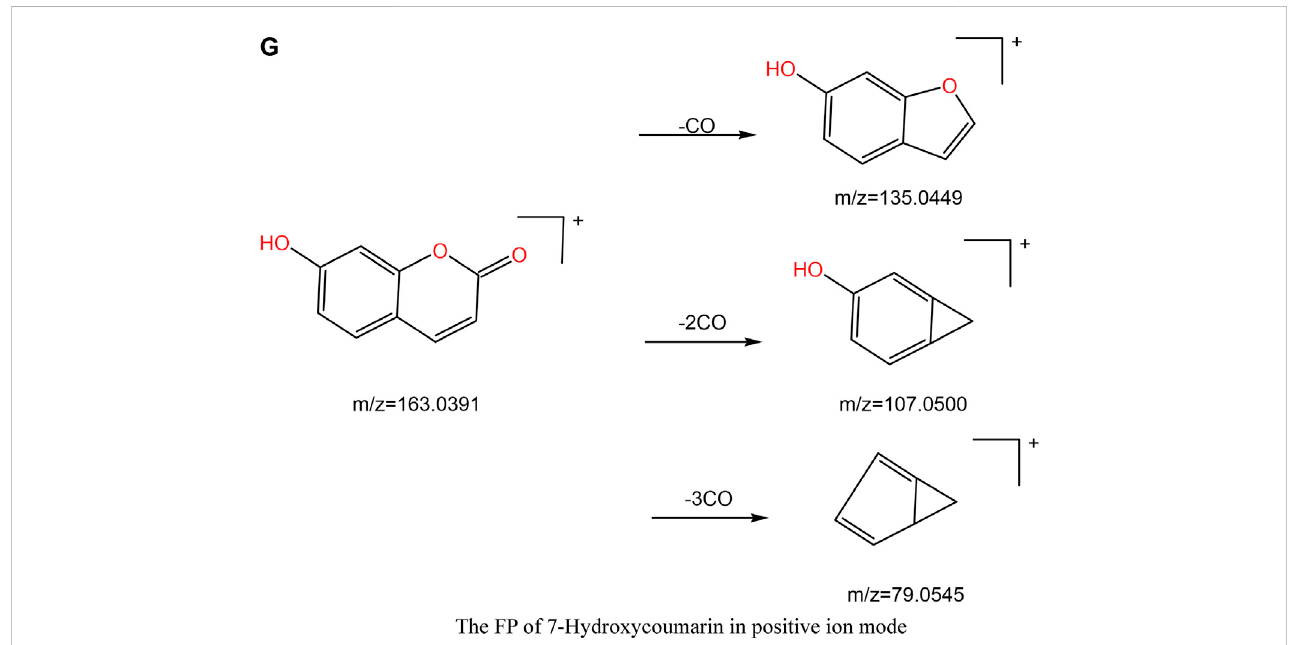
FIGURE 5 (A) MS/MS spectrogram of salvianolic acid B in negative ion mode. (B) The FP of salvianolic acid B in negative ion mode. (C) MS/MS spectrogram of rosmarinic acid in negative ion mode (A-sample, B-reference standard). (D) The FP of rosmarinic acid in negative ion mode. (E) The FP of lithospermic acid in negative ion mode. (F) The FP of terpineol in negative ion mode. (G) The FP of7-hydroxycoumarin in positive ion